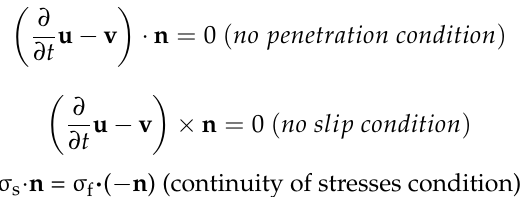
Figure 2. Representation of two computed particle bonds breaking.